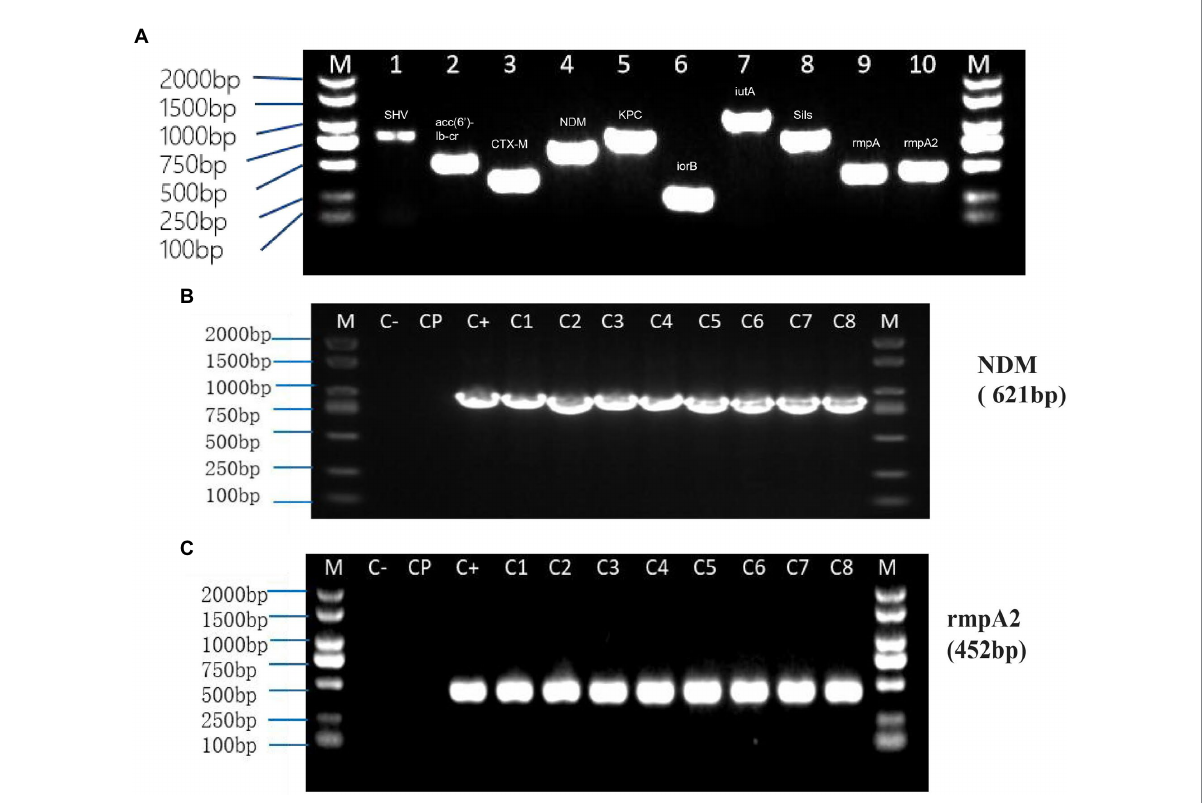
FIGURE 3 PCR from NUHL30457 omvs (A) and Colony-PCR from recipient cells treated with NUHL30457 omvs (B,C) . (A) NUHL30457omvs pcr, DNA gel showed PCR products with expected lengths. M: 2000 bp size marker1. bla SHV product~898 bp 2. acc(6 ′ )-Ib-cr product~508 bp 3. bla CTX-M